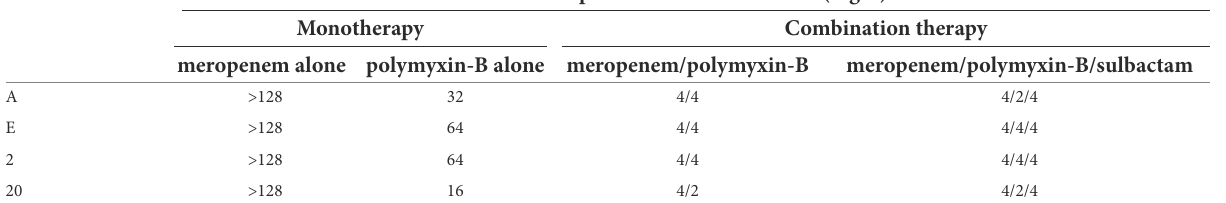
TABLE 4 Mutant prevention concentrations of meropenem and polymyxin-B alone or in combination with or without sulbactam (fixed at 4 mg/l) against four A. baumannii isolates harboring OXA-23 and other serine- β -lactamases. Clinical isolates